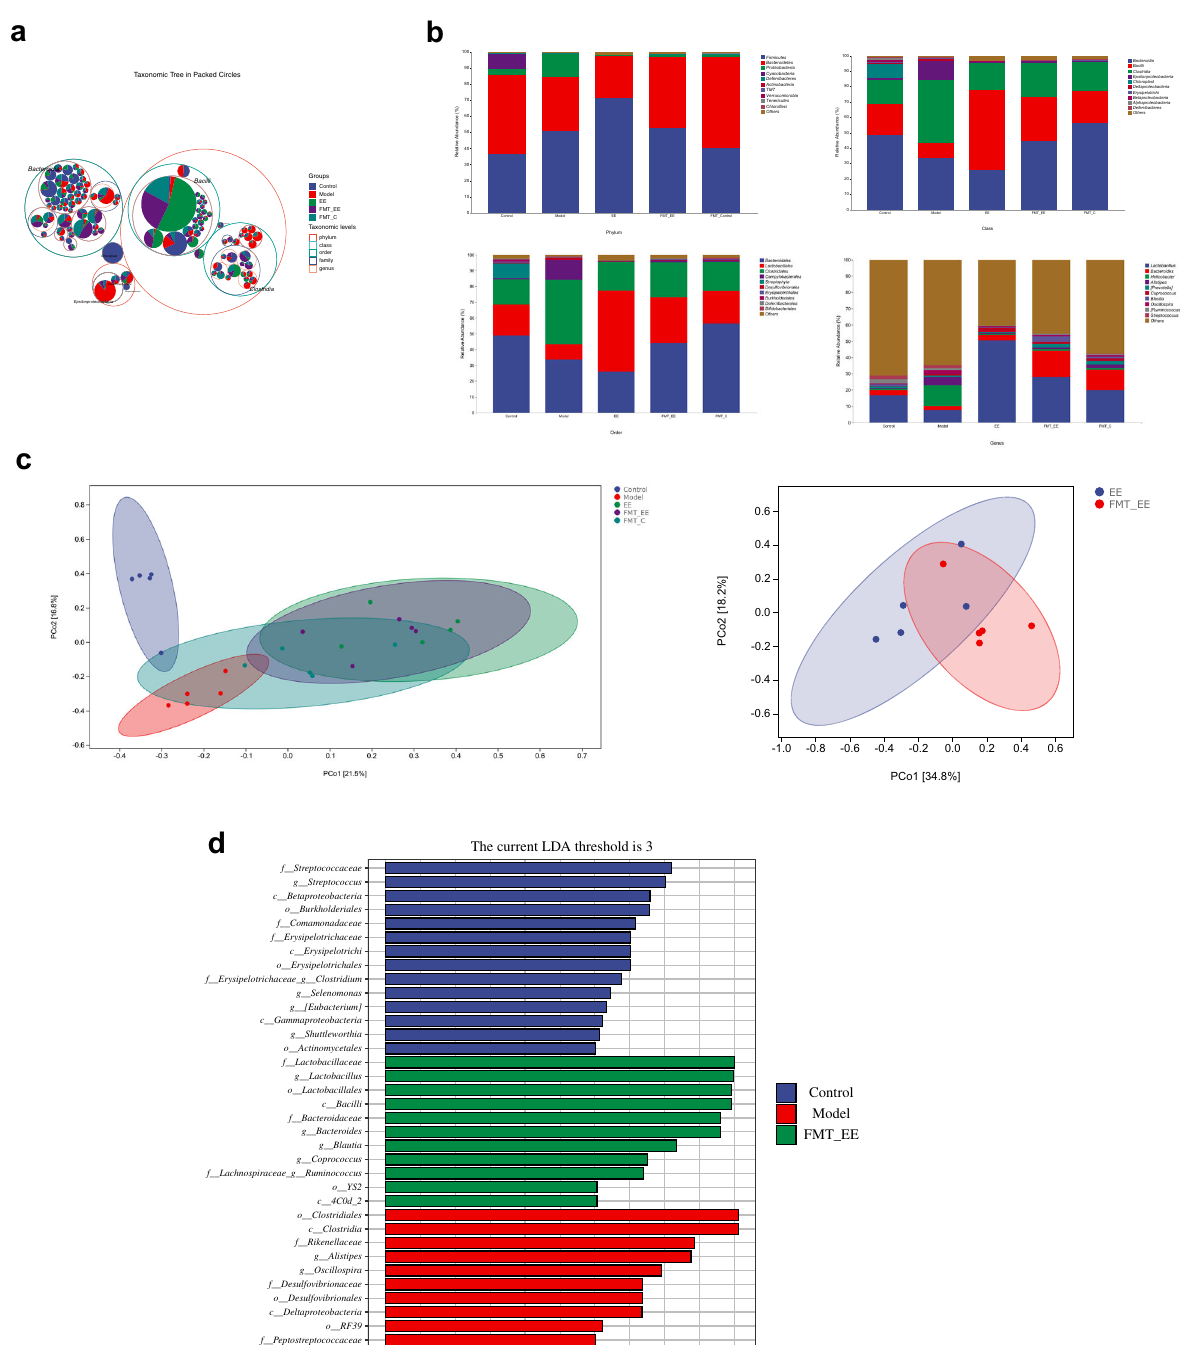
Fig. 6 FMT from EE-fed mice regulated gut microbiota composition. a Taxonomic tree in packed circles. b The relative abundance of bacteria at different level; c principal coordinates analysis plot of Bray – Curtis. d Linear discriminant analysis (LDA) effect size showing the most differentially signi fi cant abundant taxa enriched in microbiota among the model group, control group, and FMT_EE group (LDA >